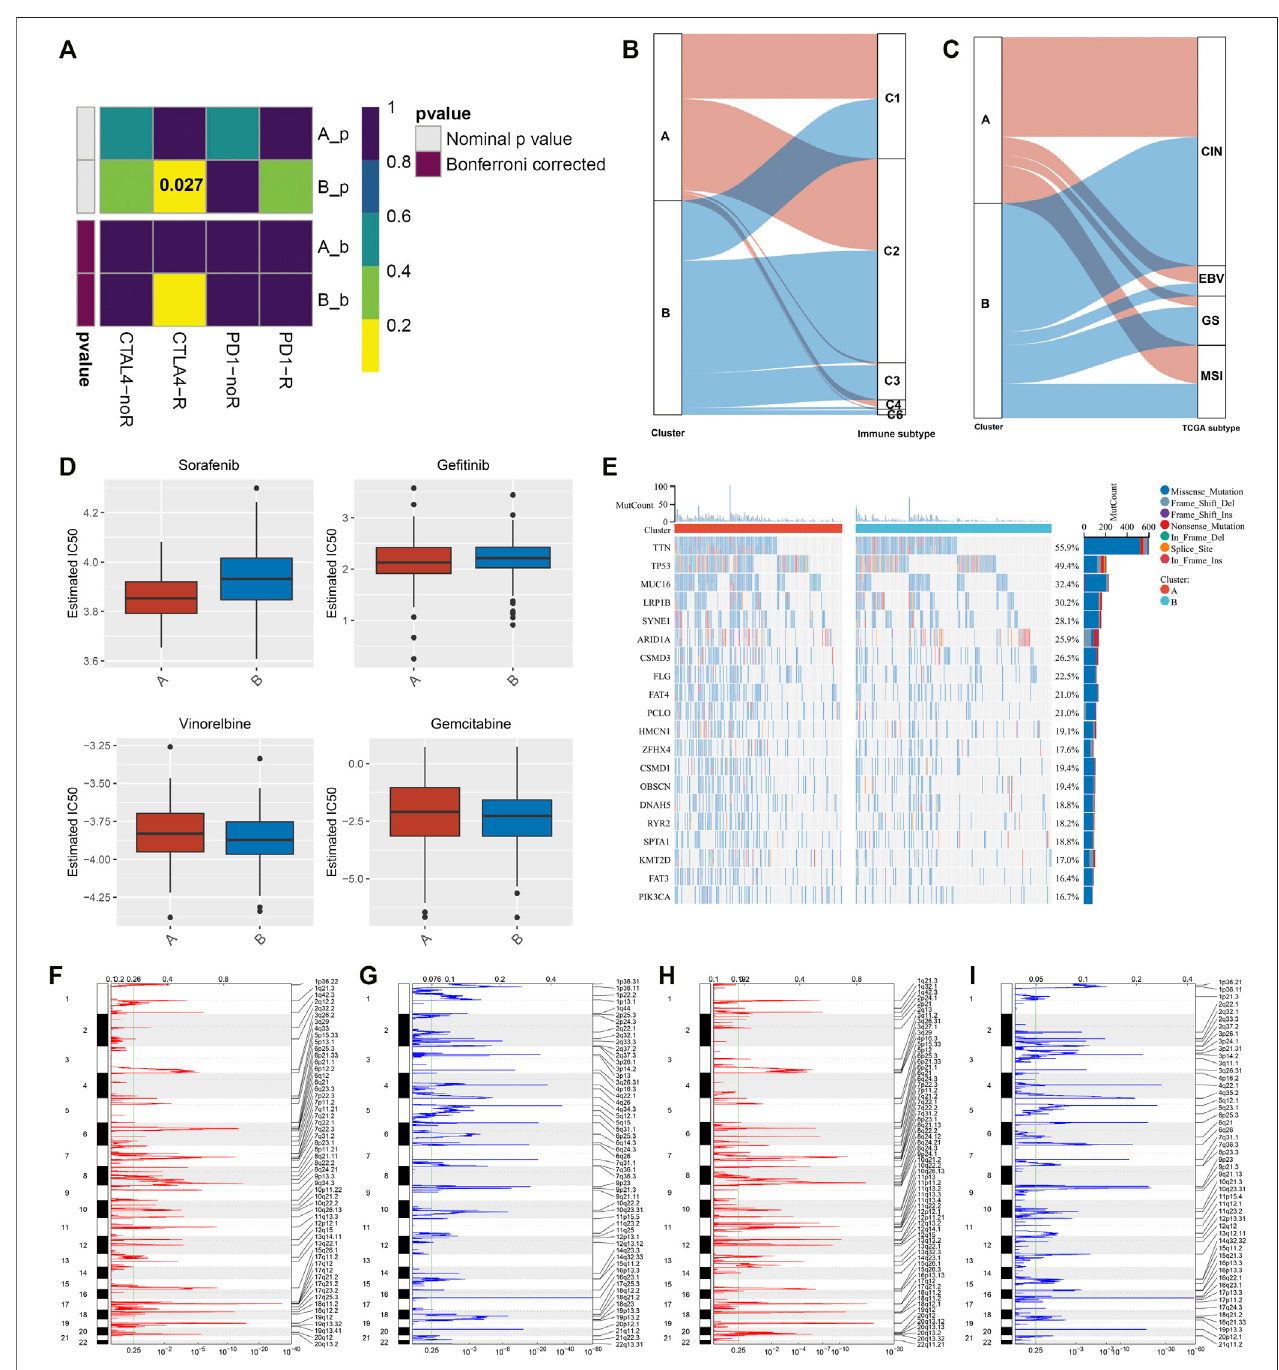
FIGURE3| ResponsestoICIs,interplaywithimmunologicalandmolecularsubtypes,drugsensitivity,andgenomicalterationsinexosome-relatedphenotypes. (A) Submap analysis of the similarity of the expression pro fi ling between GC patients in TCGA cohort and 47 previous melanoma subjects who received ICIs. (B) Alluvial diagram depicting the interactions between the two exosome-related phenotypes and immunological subtypes. (C) Alluvial diagram depicting the interactions between two exosome-related phenotypes and molecular subtypes of GC. (D) Differences in estimated IC 50 values of sorafenib, ge fi tinib, vinorelbine, and gemcitabine between the exosome-related phenotypes. (E) Mutational frequency of the top 20 genes in two exosome-related phenotypes. Gene symbols are ranked in accordance with the frequency of gene mutation. Each column indicates each specimen and the upper panel indicates TMB. (F – I) Somatic copy number alterations in exosome- related phenotype (F , G) A and (H , I) phenotype B. On the x-axis, focal ampli fi cation or deletion is separately represented by red or blue bars. The position of chromosomes is shown along the y-axis. The green line indicates the signi fi cance threshold of q < 0.25.